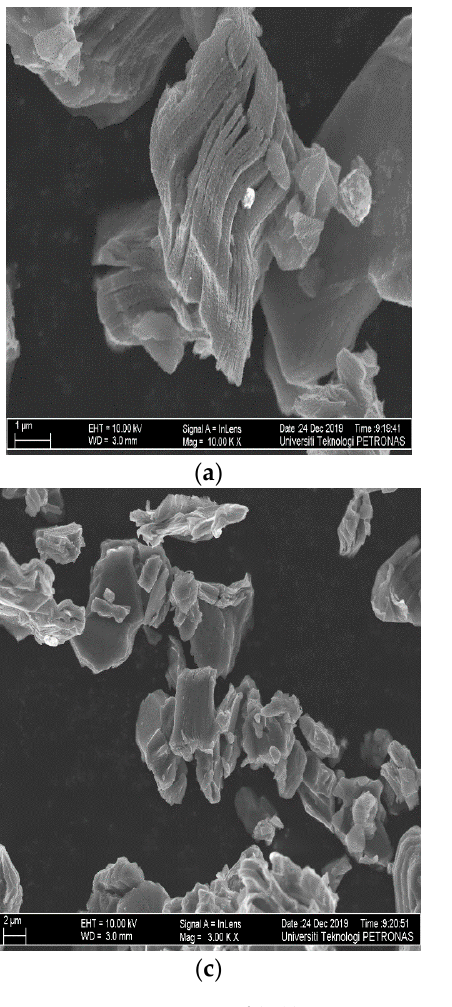
Figure 2. FESEM images of ( a , b ) Cross-sectional view of Ti 3 C 2 MXene after drying ( c , d ) Top view of the synthesized Ti 3 C 2 MXene after delamination.